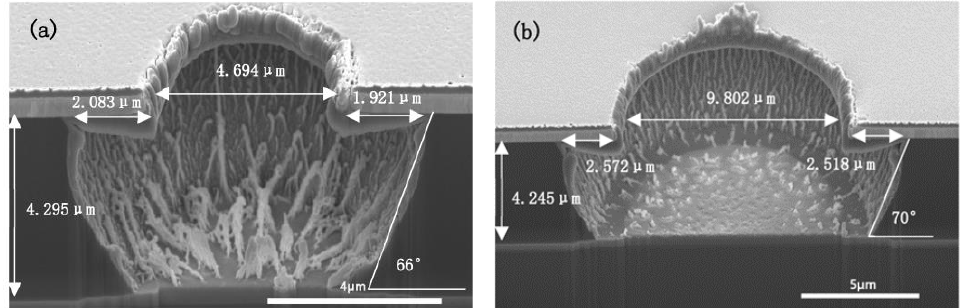
Figure 10. ICP etching of fully cured PI under 2500 W ICP power, 500 W RF power, 10% CHF 3 ratio, 100 sccm gas flow and 3 min. (( a ) the via diameter is 4 μm ; ( b ) the via diameter is 9 μm )